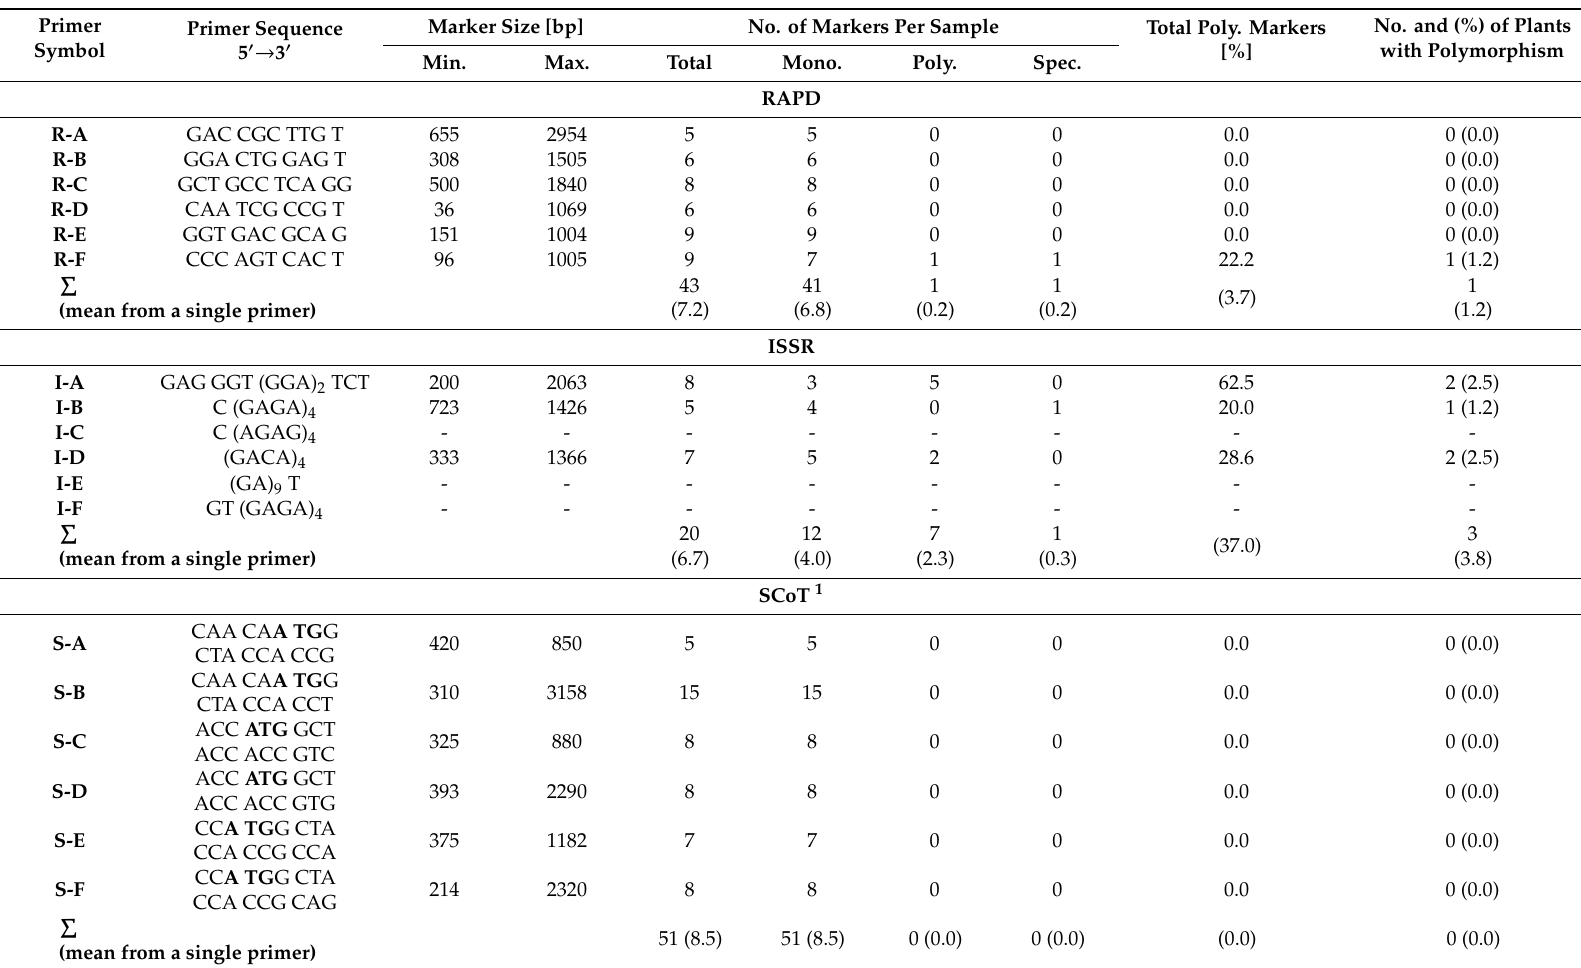
Table 3. Characteristics of molecular products and number / share of plants with polymorphisms detected with RAPD, ISSR, and SCoT